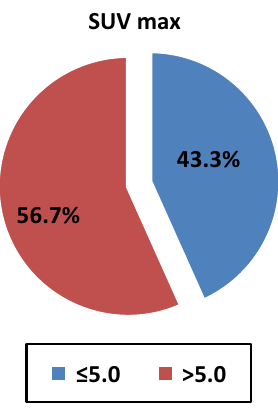
Fig. 3 Pie chart showing the SUVmax for FDG uptake in patients included in the study